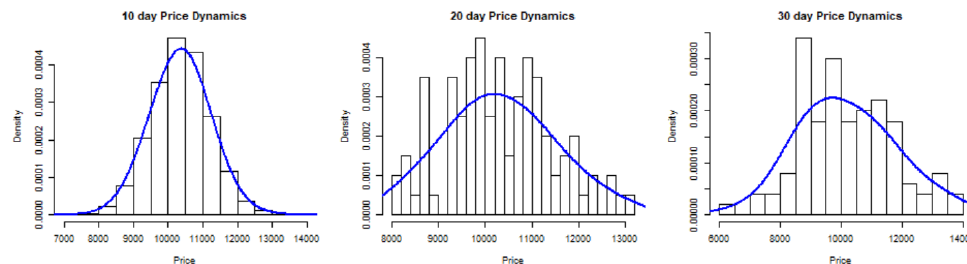
Figure 5. Distribution dynamics of Bitcoin prices at ∆ t = 10,20,30.